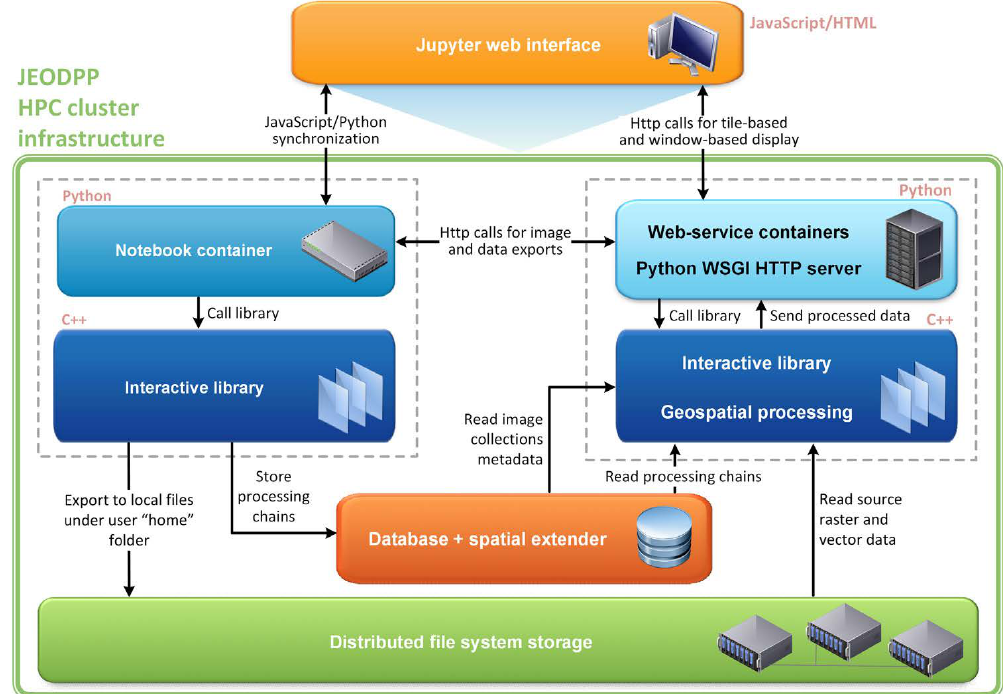
Figure 5. System architecture for interactive visualization and processing ofEarth observation (EO) data on Joint Research Center (JRC) Earth Observation Data and Processing Platform (JEODPP) platform. Source: Soille et al.